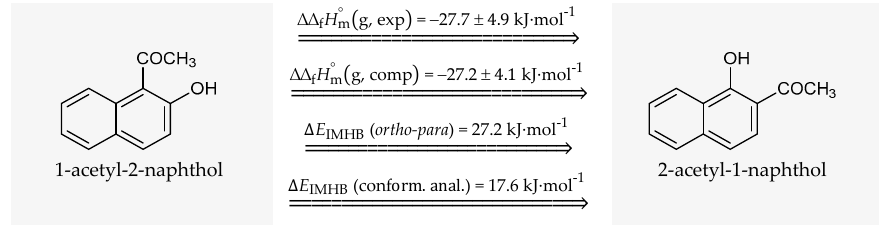
(Table 4). On the other hand, the entropic factor promotes additional stability to the crystal phase of 1-acetyl-2-naphthol leading to a high stability of this one, as can be confirmed by ∆ g it more